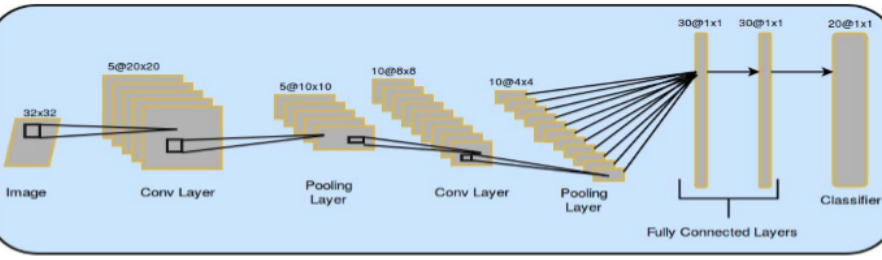
Figure 1. Basic architecture of a convolutional network [34].